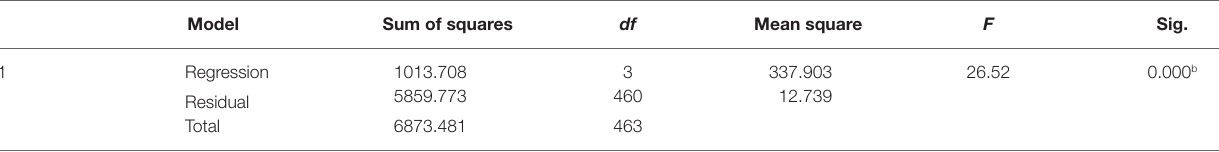
TABLE 4 | ANOVA for teachers’ resilience and their emotions. Model